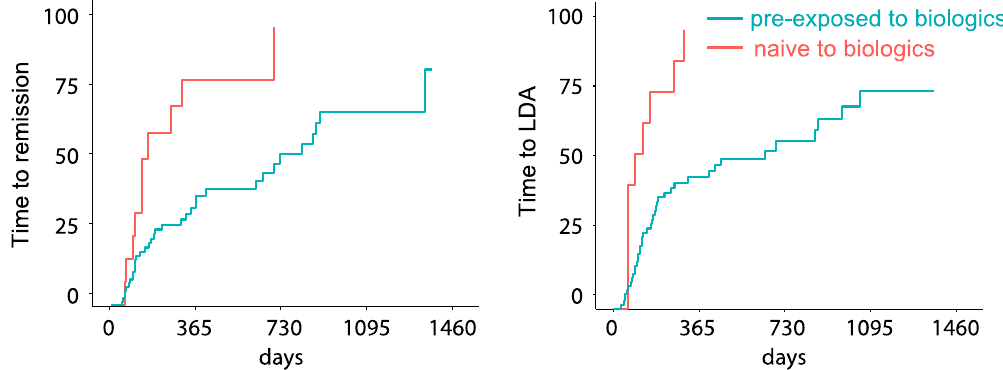
Figure 2. Disease activity: Time to remission (left panel) and low disease activity (LDA, right panel) is shown for all RA patients treated with tofacitinib. Patients previously exposed to biologic agents are shown in green, and patients naïve to biologics in red.